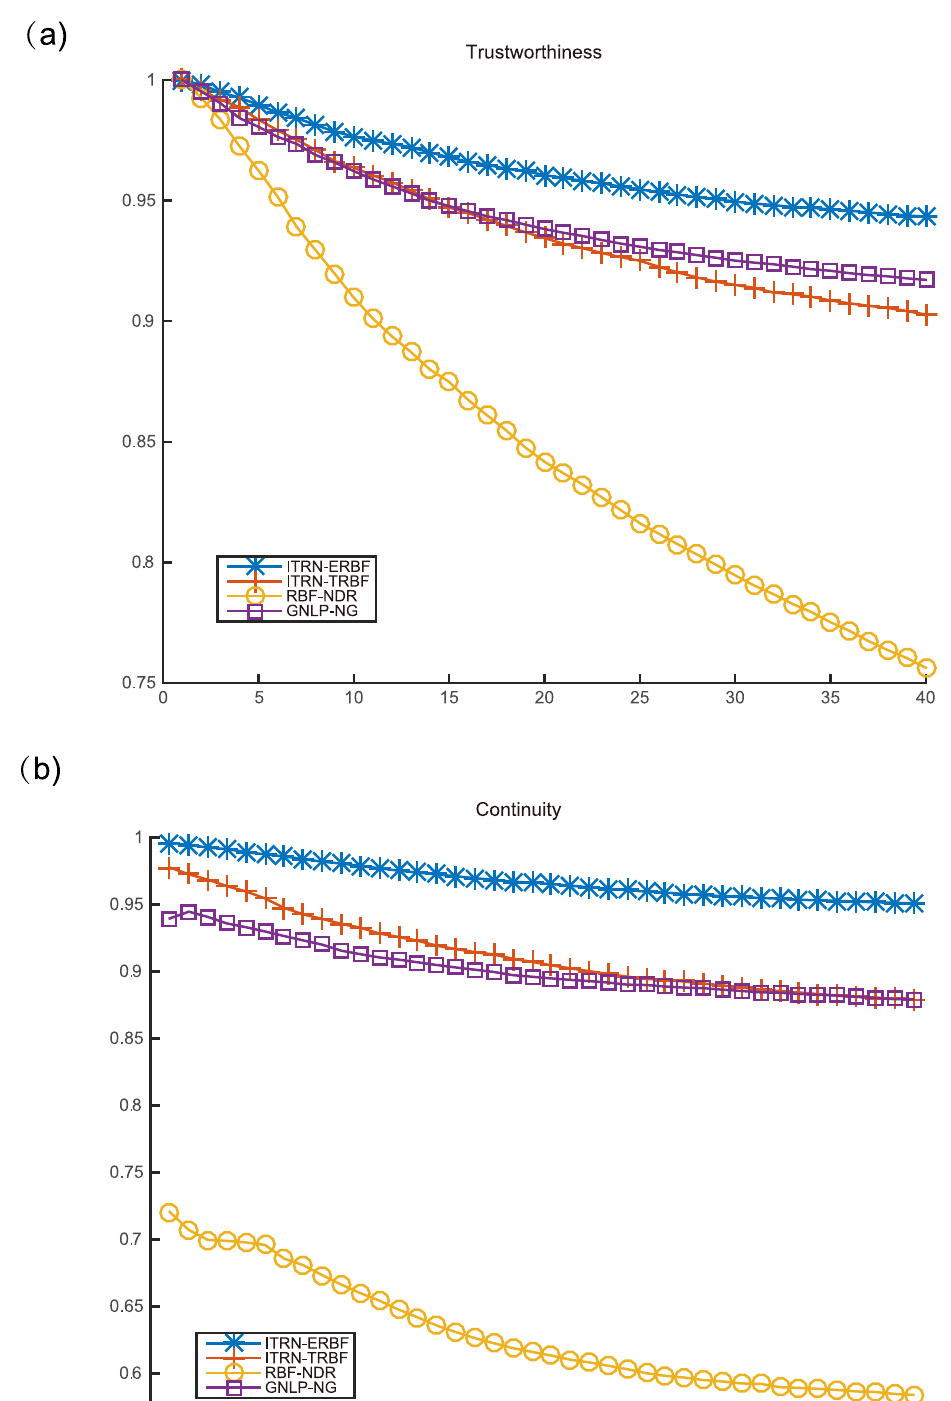
Fig 12. Mapping quality for handwritten digit “ 2 ” .